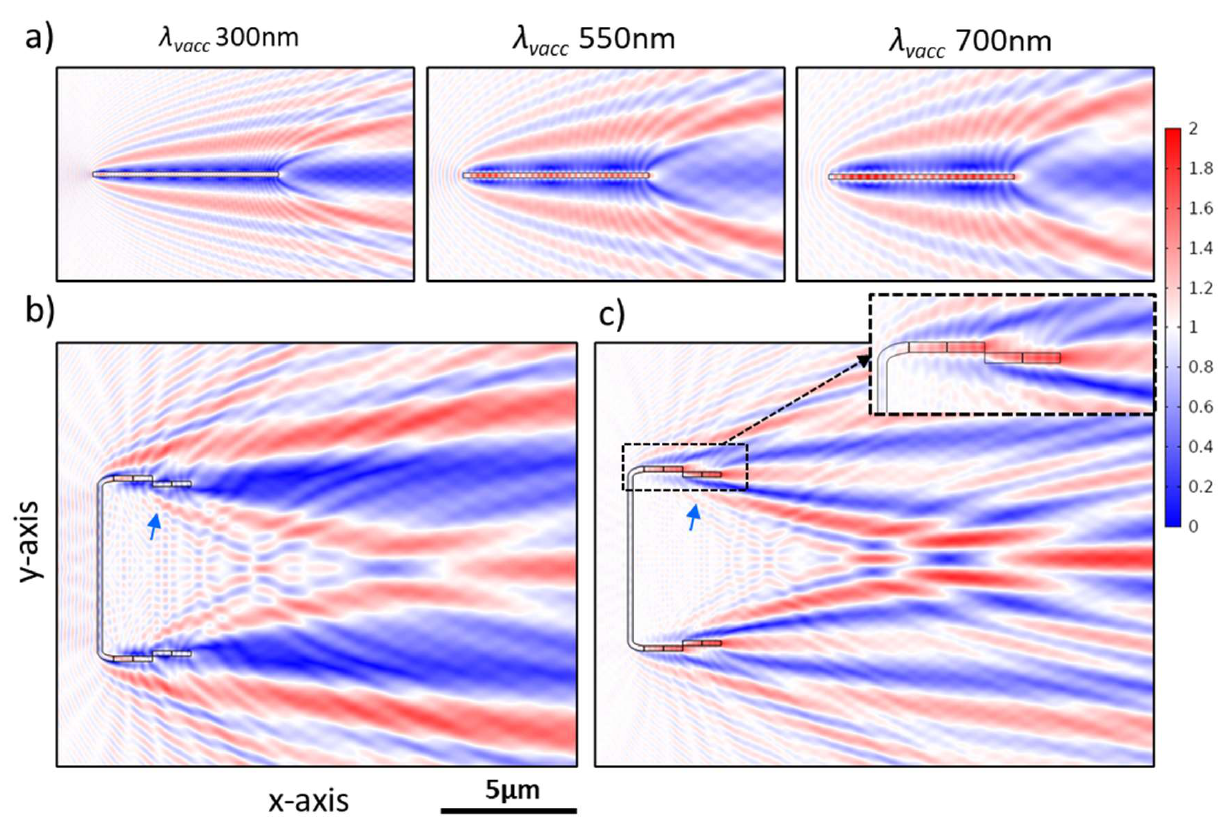
Figure 6. S ana,M of height h sl = 2 µm in air ( a ), CS long,5 with four girdle bands in air ( b ) and in water ( c ) at λ vacc 550 nm. The zoom inset in ( c ) seemingly shows a coupling behavior in water that is not observed in air ( b ).